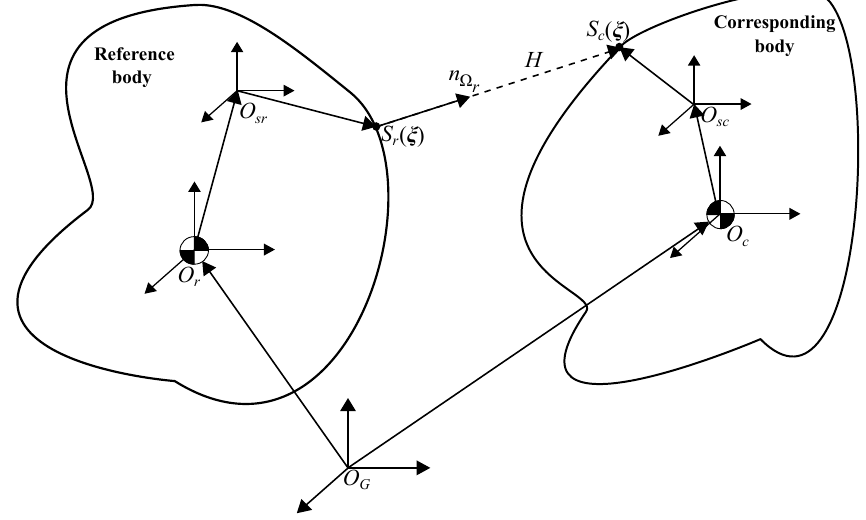
Figure 2: Generic joint with clearance in a multibody